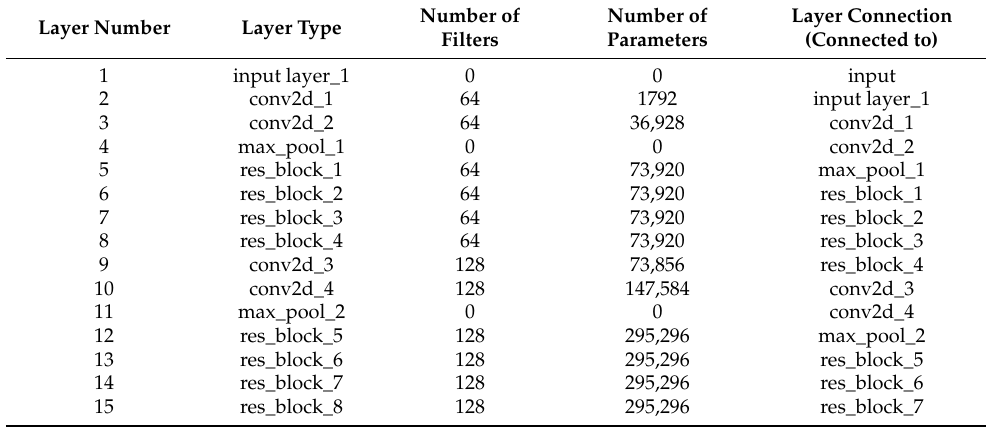
Table 8. Description of the proposed